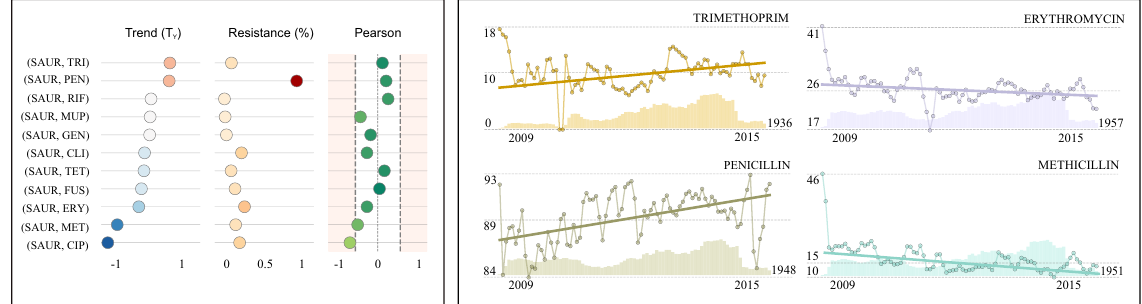
Figure 5. Case study III: S.aureus in wound samples. The table presents the resistance index, resistance trend (monthly and yearly), the Pearson correlation coefficient, the number of isolates and external resources for validation for each antimicrobial. In addition, the main metrics ( left ) and four examples of resistance time series ( right ) are graphically represented to facilitate